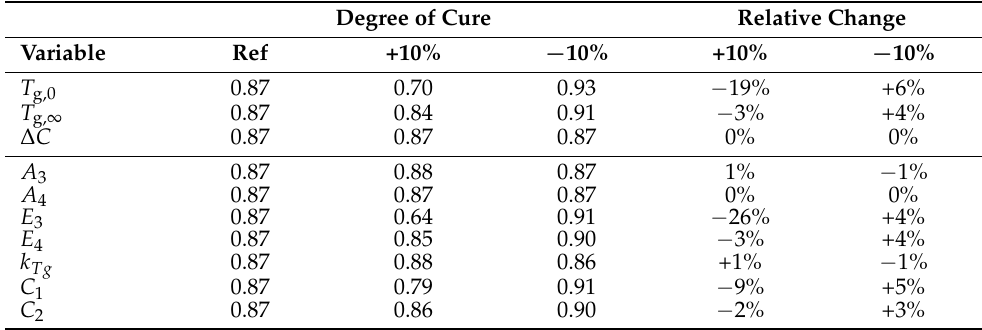
Table 5. Sensitivity analysis by varying the